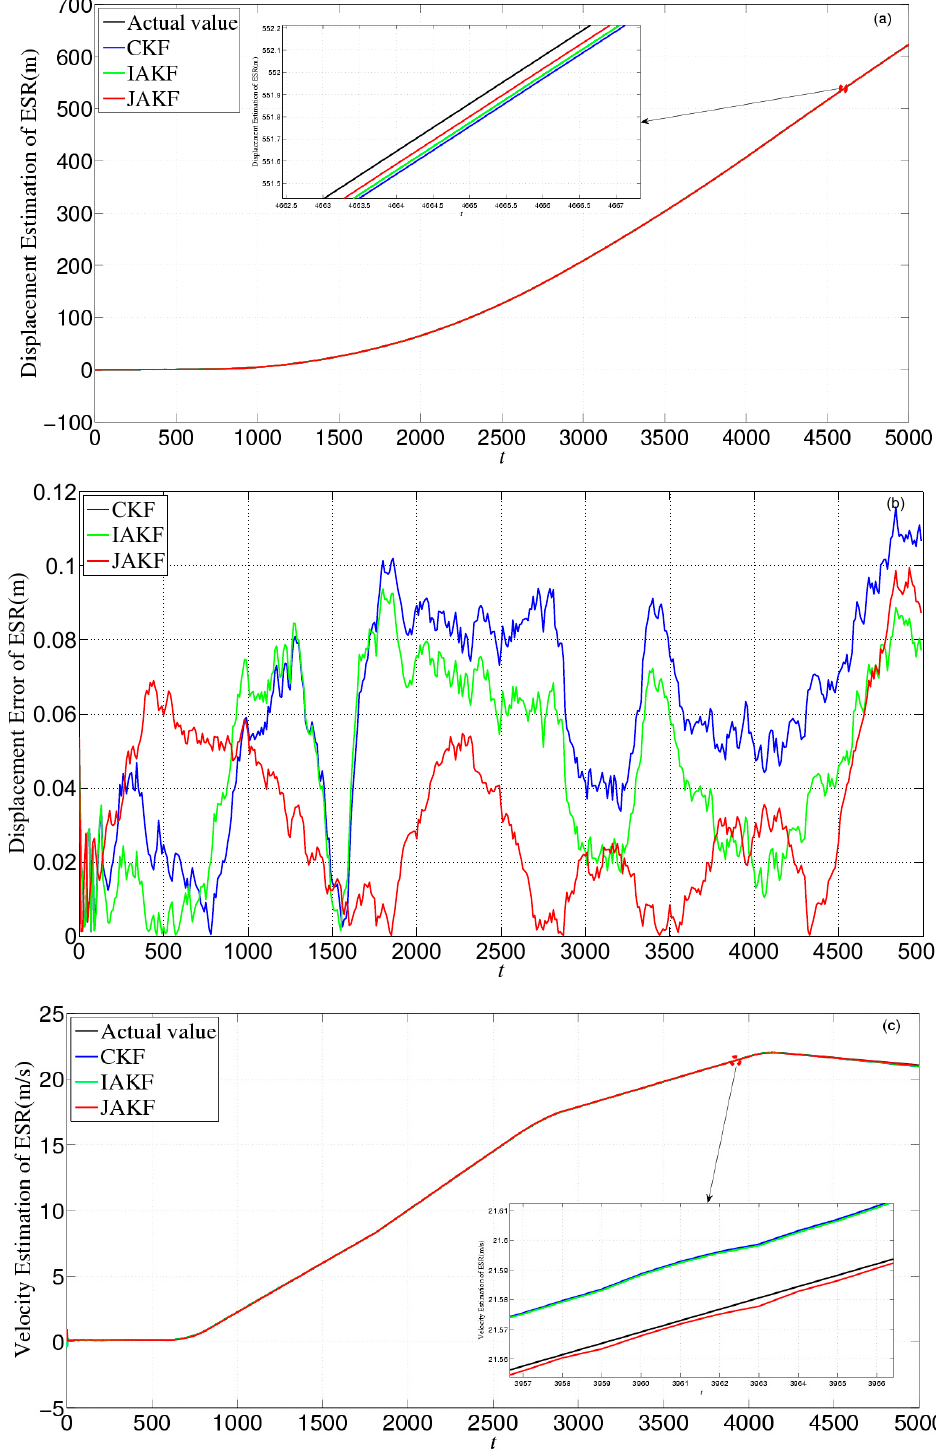
Figure 15. Figure 15 . Cont .